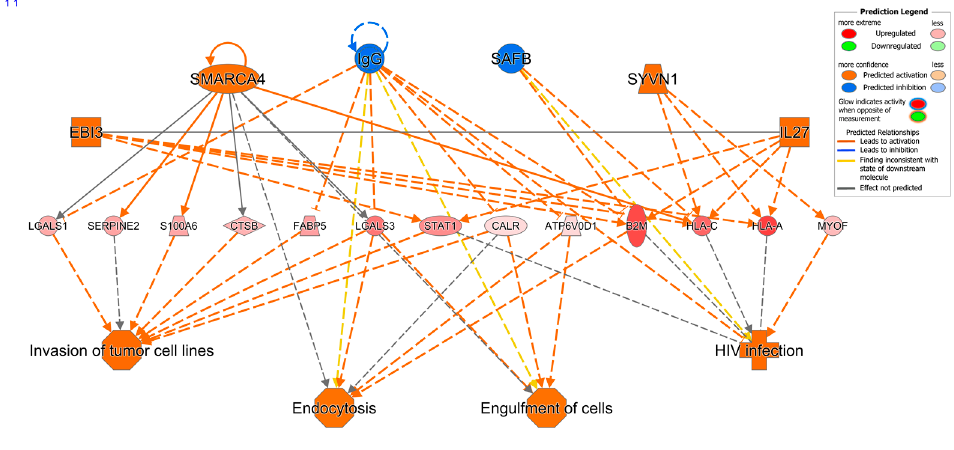
Figure 4. Regulatory effects network. The above upstream regulator effects network was predicted by the IPA bioinformatic analysis of the 191 DE proteins elevated in metastasizing pUM. Symbols: circle, complex/group; square—cytokine; vertical oval—transmembrane receptor; horizontal oval—transcription regulator; trapezoid—transporter. Solid lines represent direct interactions; dashed lines represent indirect interactions. IPA predicted no regulatory effects network for DE proteins elevated in non-metastasizing pUM.